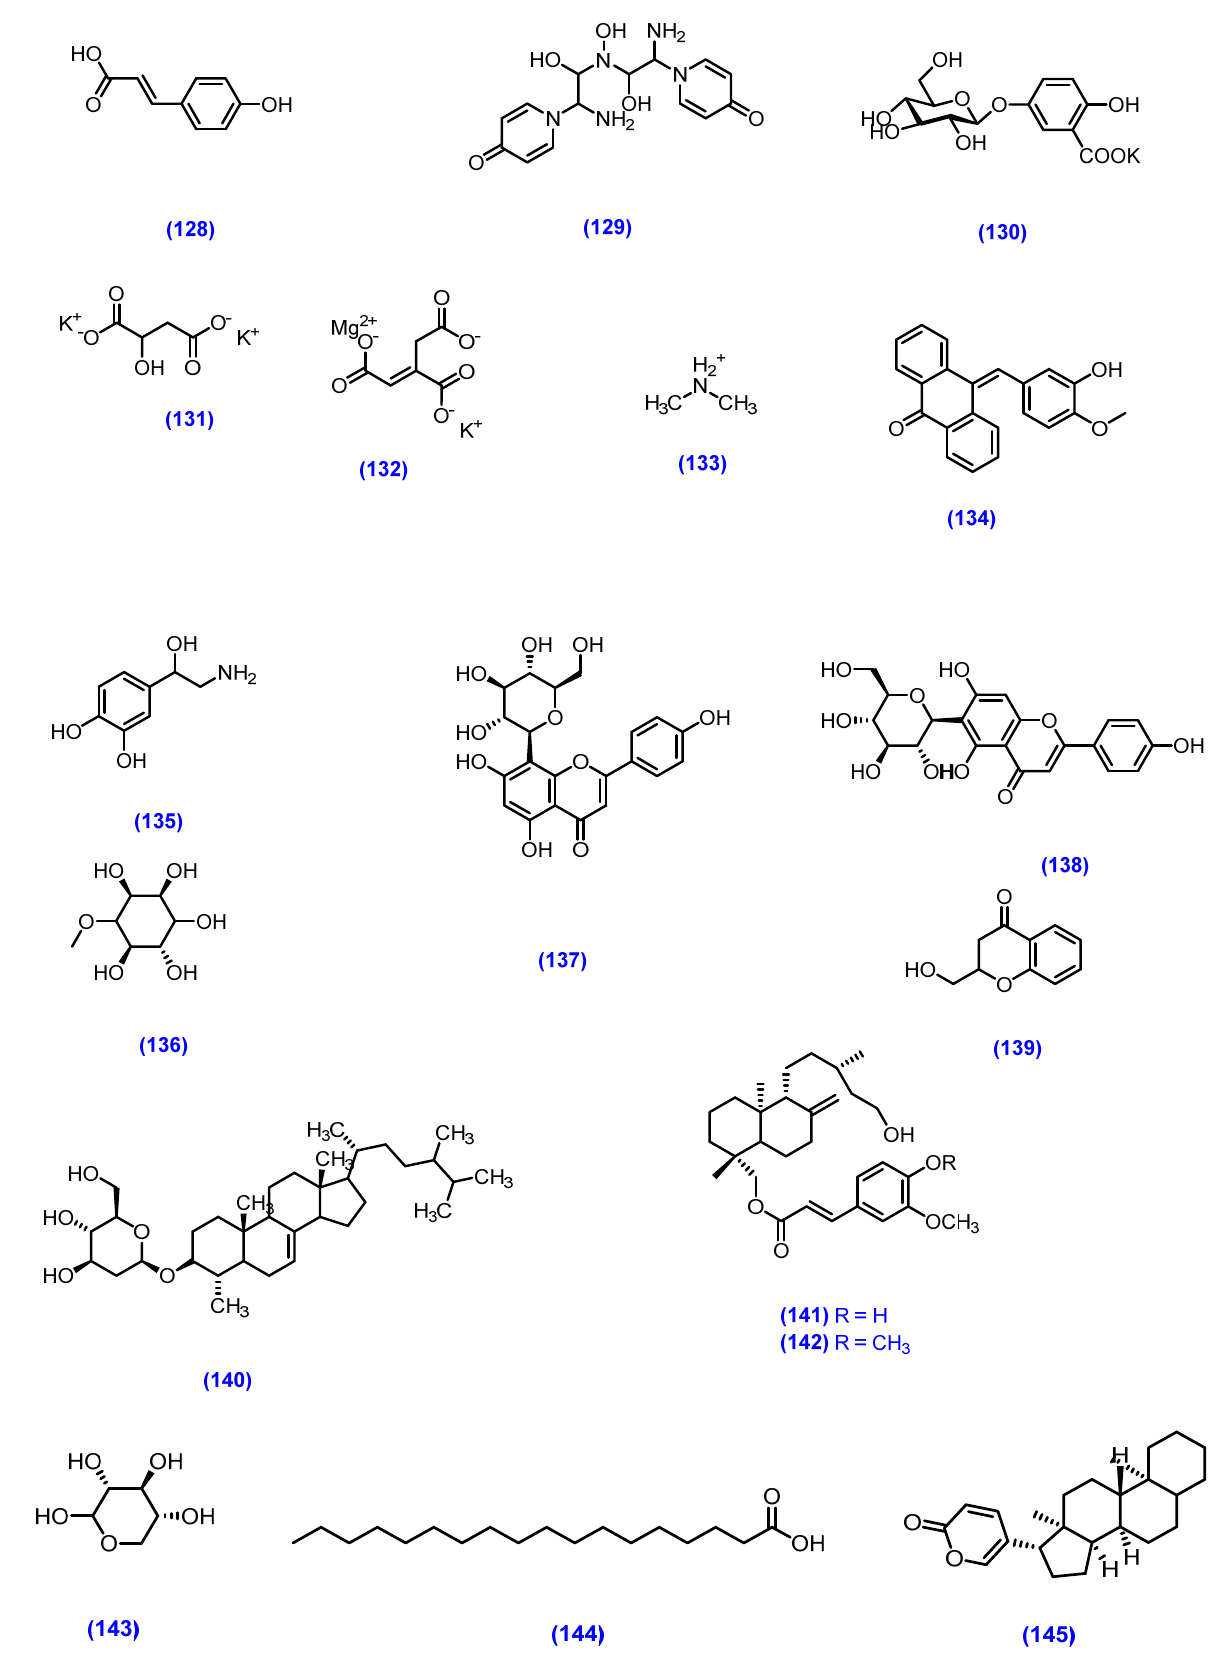
Figure 1. Bioactive constituents isolated from various species of genus Mimosa.